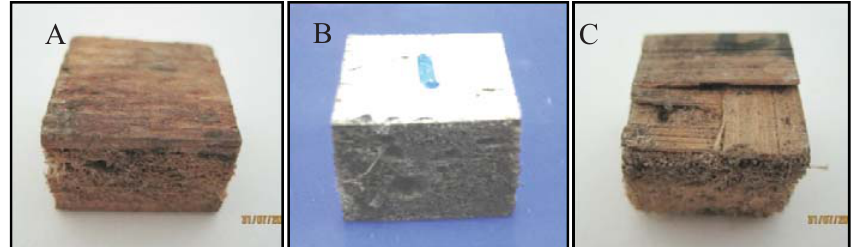
overlaid ( B ) and betung bamboo matting overlaid ( C )